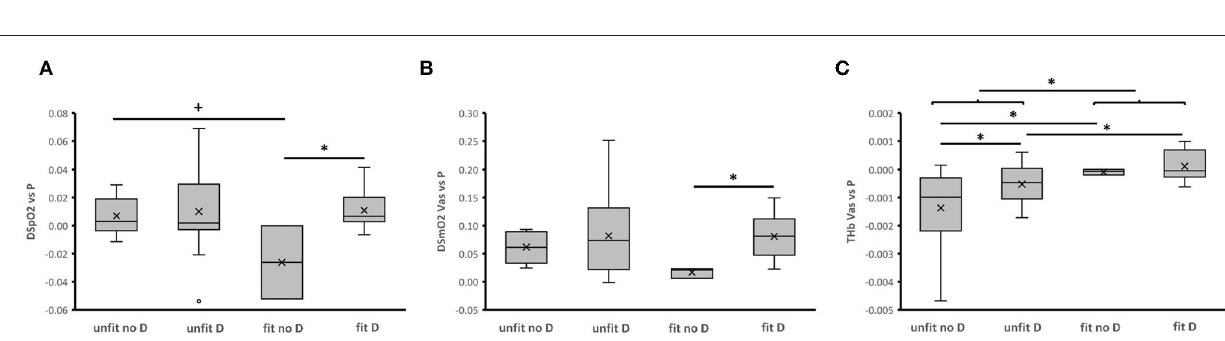
FIGURE 5 | ACE-I/D genotype and aerobic fitness associated differences in the control coefficients for aspects of aerobic metabolism. Box-Whisker plots of the fitness- and ACE-I/D-genotype dependent control coefficients for DSpO 2 (A) , DSmO 2 Vas (B) , and THb Vas (C) respective to power output during the different metabolic phases of the ramp exercise test. Box, first and third quartile; central line, median; x, mean; whisker, minima-maxima. + ,*Indicate p < 0.10 and < 0.05, respectively, for the indicated comparison. Swung brackets refer to data from a same fitness state. ANOVA with post-hoc test of least significant